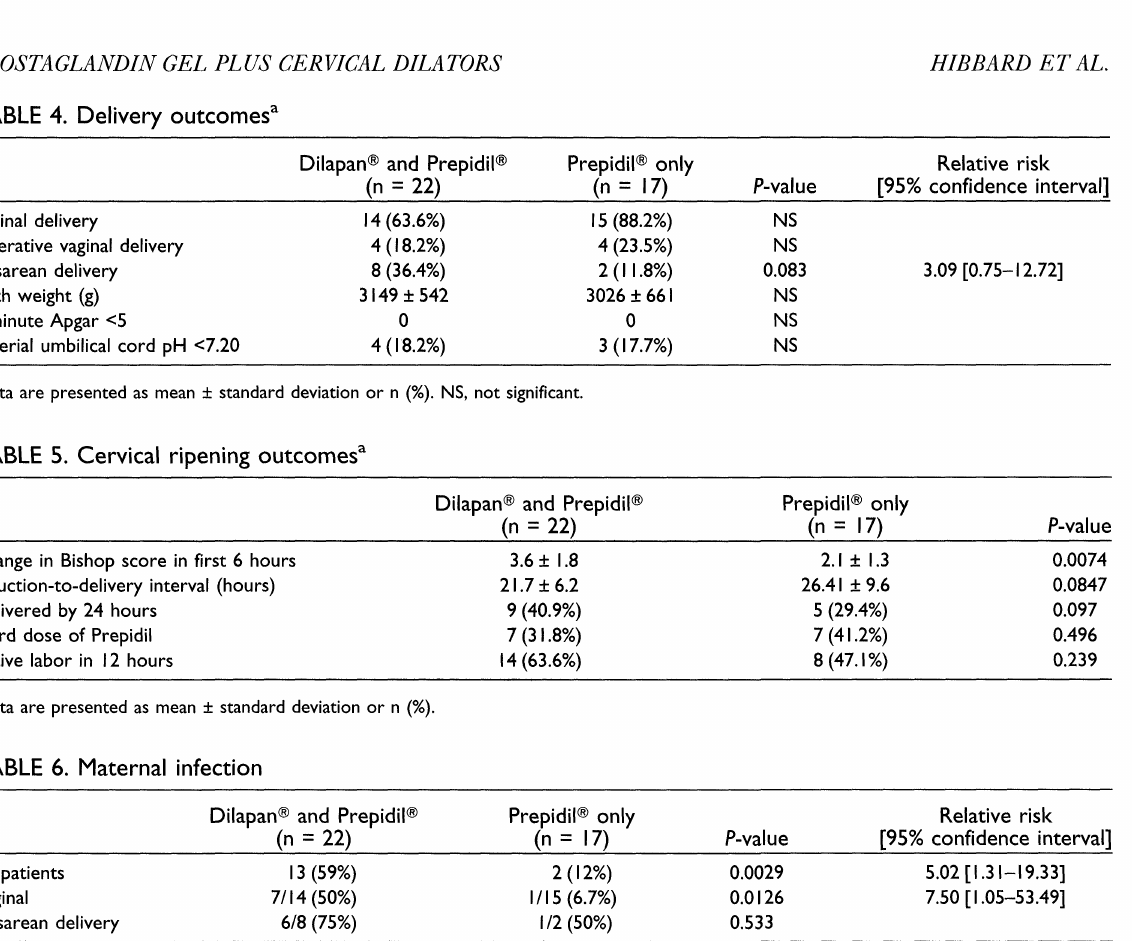
TABLE 4. Delivery outcomes Vaginal delivery Operative vaginal delivery